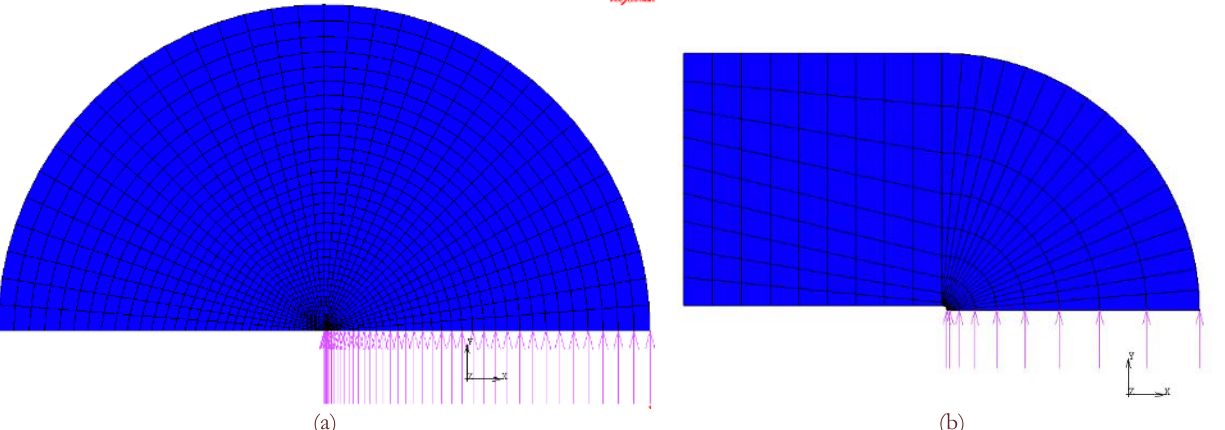
Figure 1: Finite element mesh for MBL: a) whole model, b) detail of the near tip region showing the initial crack blunting. Arrows indicates symmetry boundary conditions applied as constrained displacement to the